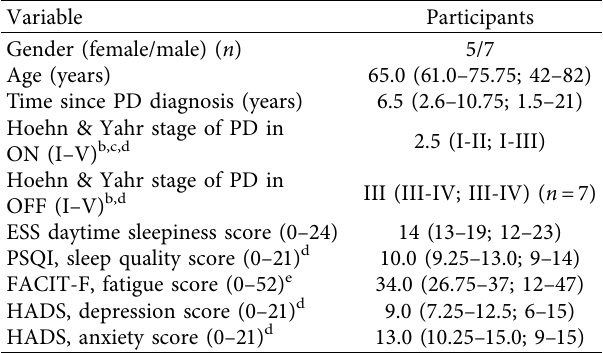
Table 1: Sample characteristics ( n � 12) a